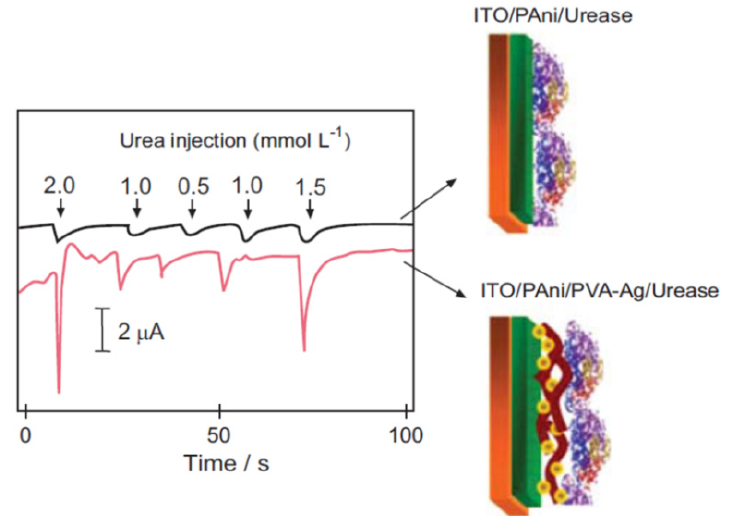
Figure 29. Chrono-amperometric curves at different urea concentrations for ITO/PAni/urease (black line) and ITO/PAni/PVA-AgNP/urease (red line) electrodes. Applied potential: 0.0 V (Ag/AgCl). Electrolyte: phosphate buffer 0.1 mol·L − 1 . (Reproduced with permission from [137], Copyright Elsevier